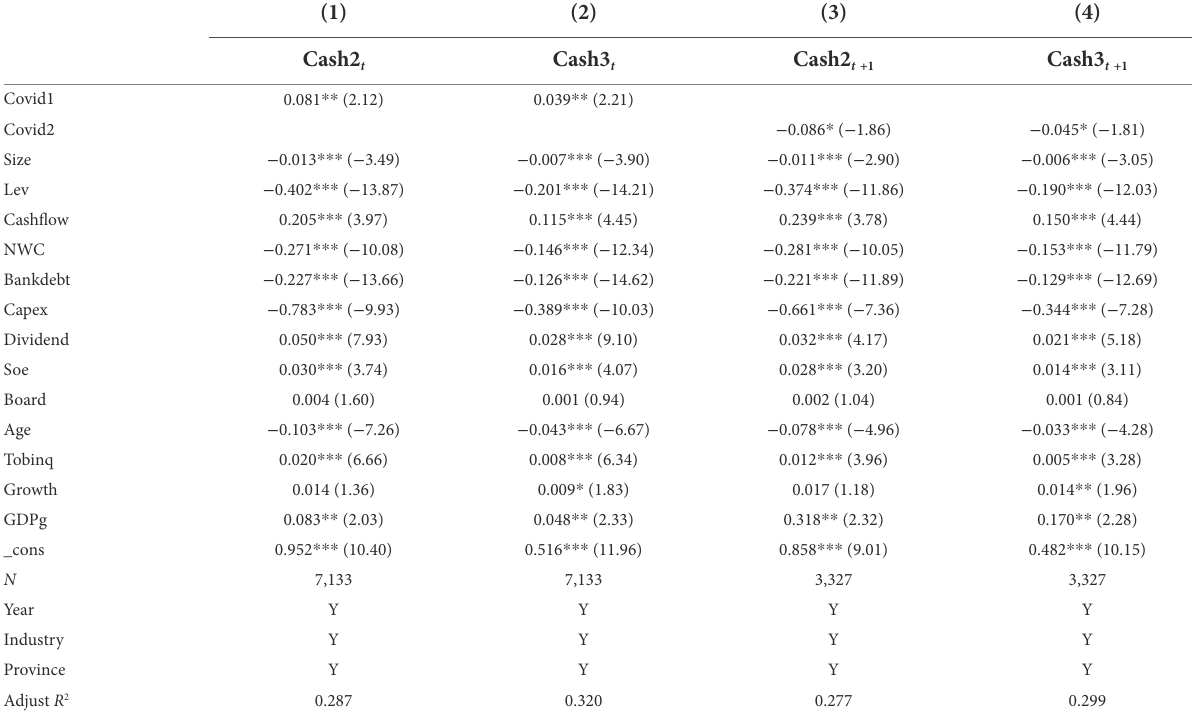
TABLE 5 COVID-19 impact and corporate cash holdings: a measure of changing dependent